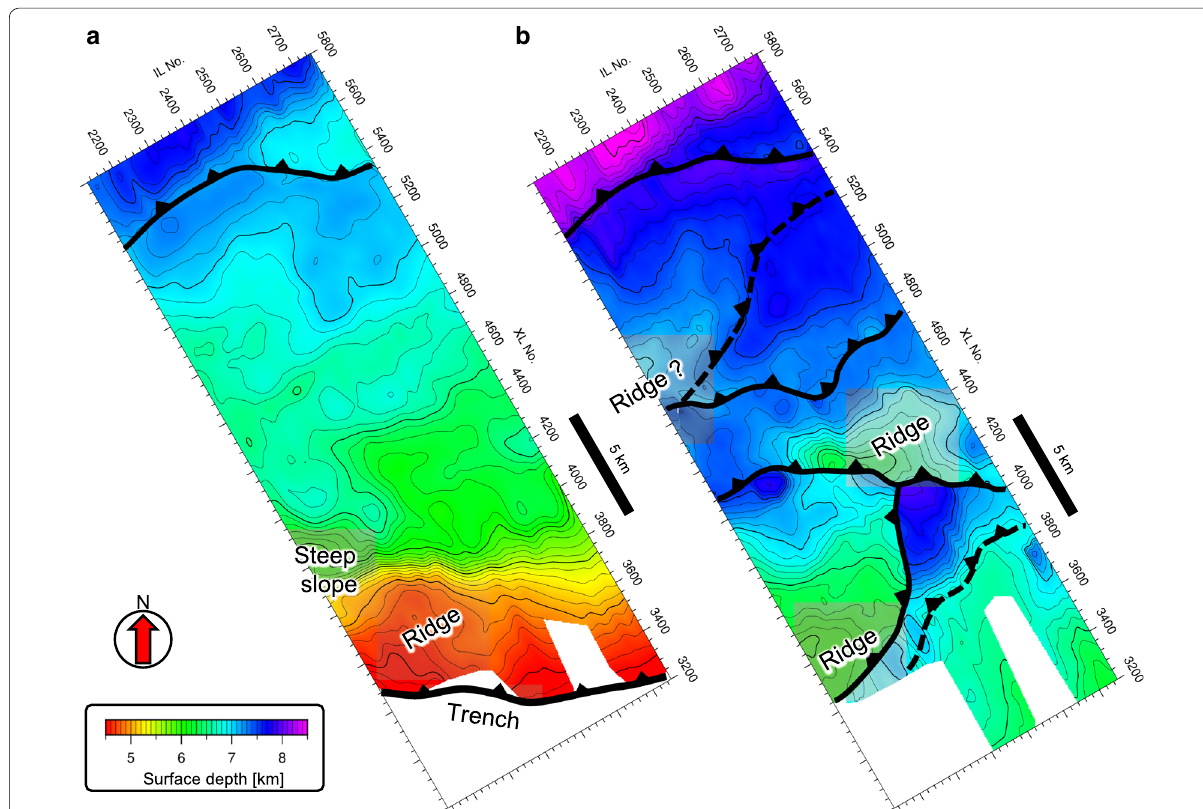
Fig. 4 Interpreted horizons of ( a ) the décollement and ( b ) the top of the oceanic crust. The black lines with triangles denote faults (and trench in ( a )). The décollement is generally a gently sloping surface and has a locally steep slope in the SW area. The top of the oceanic crust has prominent topographic relief due to faults in the oceanic crust, and there are ridges on the